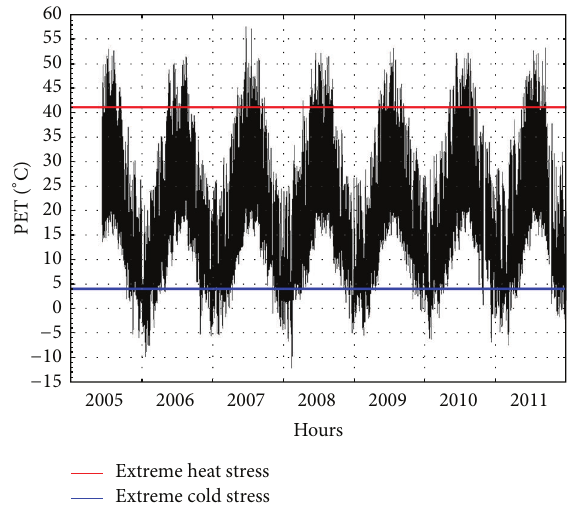
Figure 5: The time series of hourly PET values along with extreme heat (PET > 41 ∘ C) and cold stress (PET < 4 ∘ C) thresholds, for the period 15/06/2005–31/12/2011.